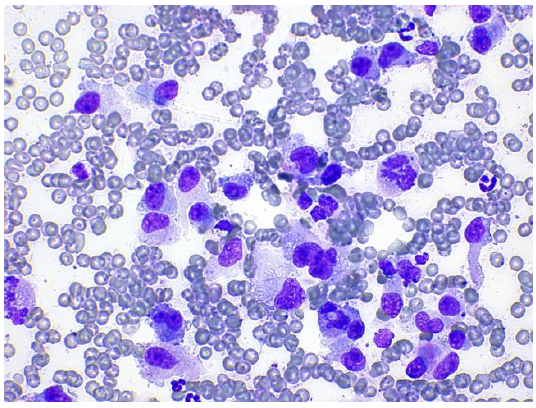
Figure 5. Mesenchymal cells with mild to moderate atypia consistent with sarcoma (case 6). Modi- fied-wright stain, 40×.